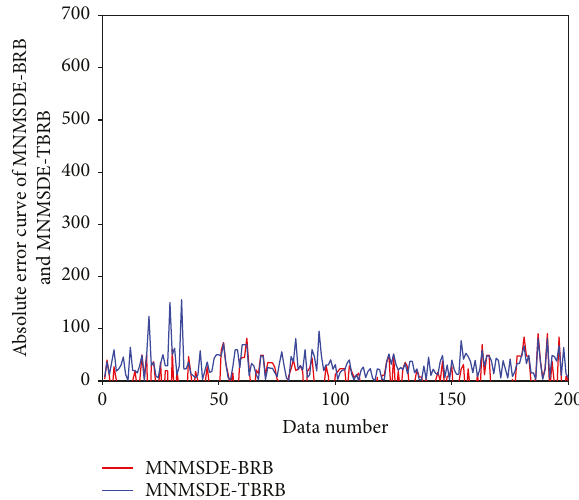
Figure 7: The absolute error of MNMSDE-BRB and MNMSDE- TBRB.